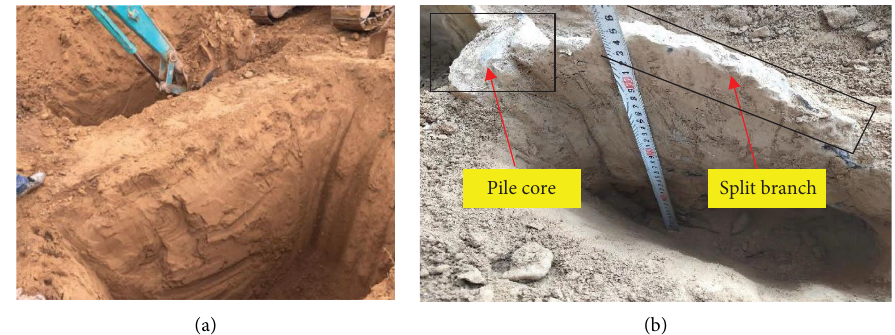
Figure 11: Site excavation: (a). Pile excavation; (b). Pile composition.